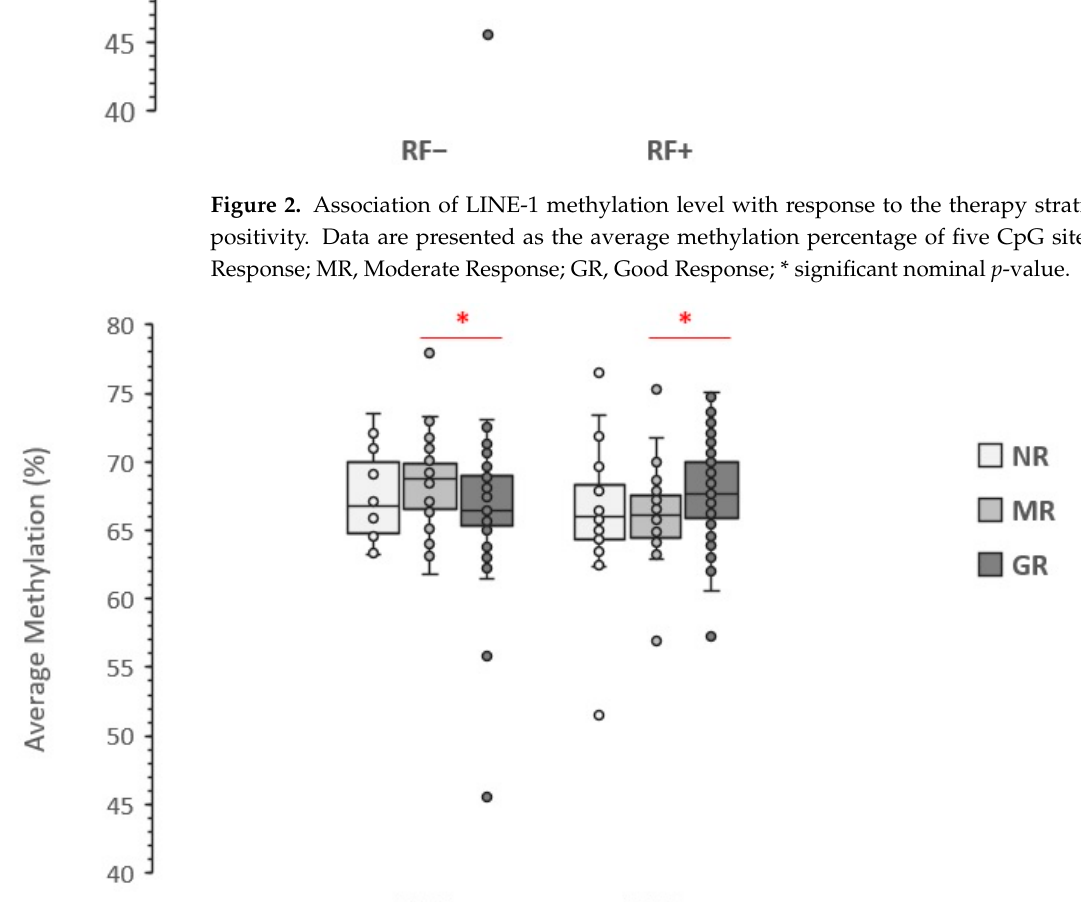
Figure 2. Association of LINE-1 methylation level with response to the therapy stratified by RF pos- itivity. Data are presented as the average methylation percentage of five CpG sites. NR, No Re- sponse; MR, Moderate Response; GR, Good Response; * significant nominal p -value.